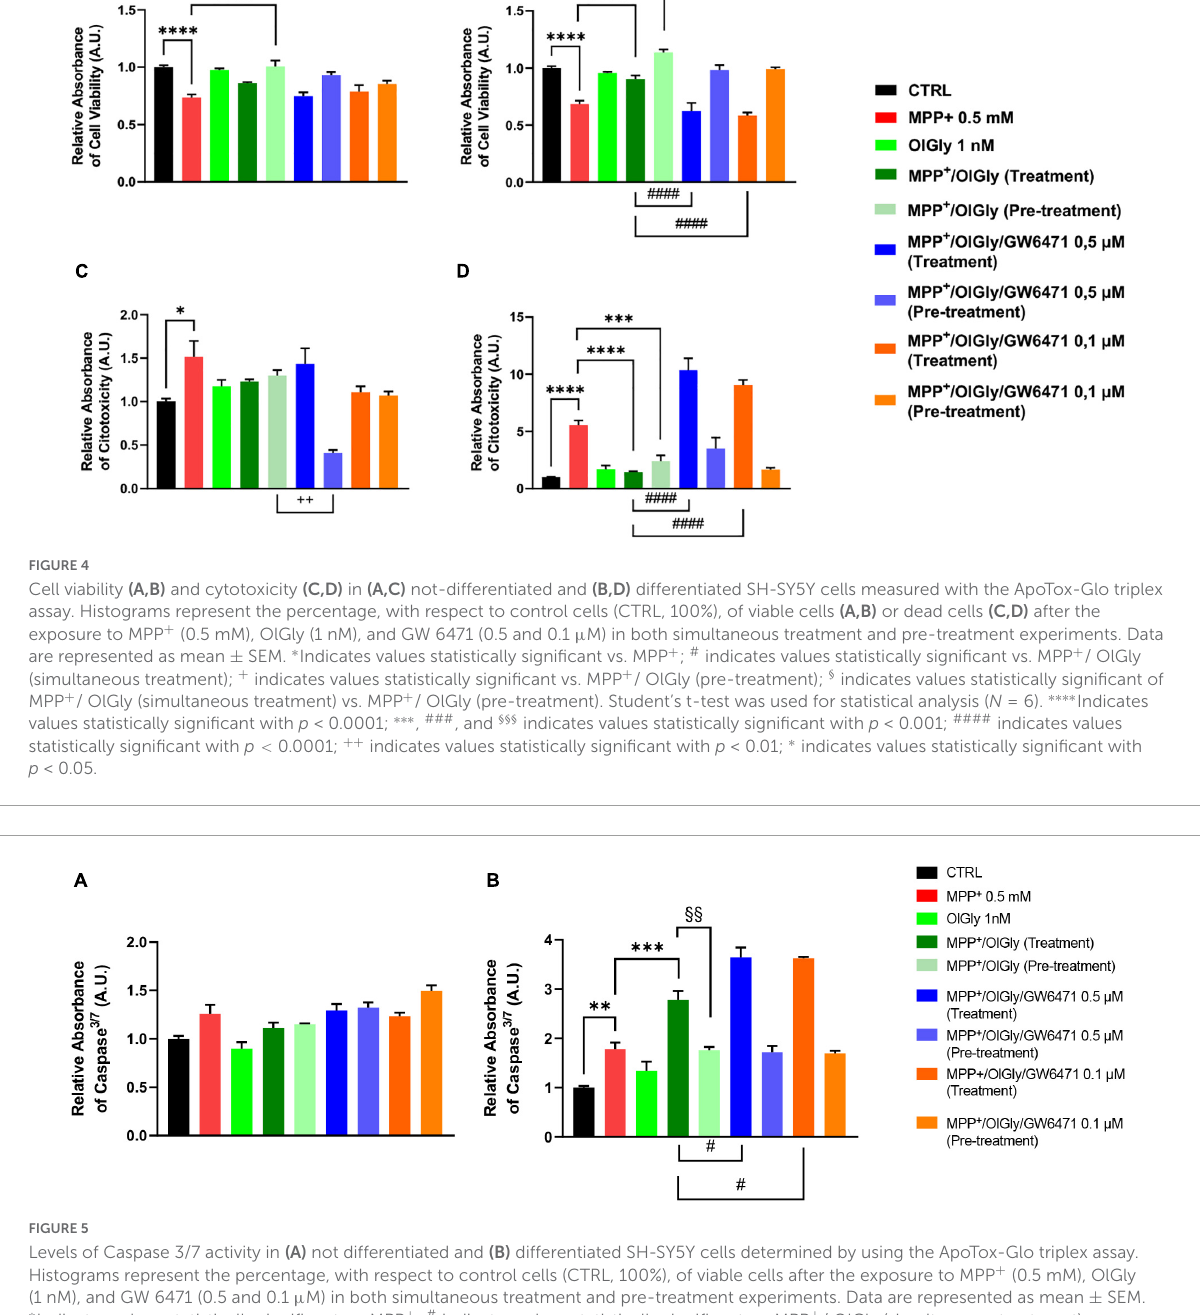
study, TH levels were measured using Western blotting. As shown in Figure 6 , TH expression was decreased in MPP + - induced SH-SY5Y cells compared with control cells. OlGly